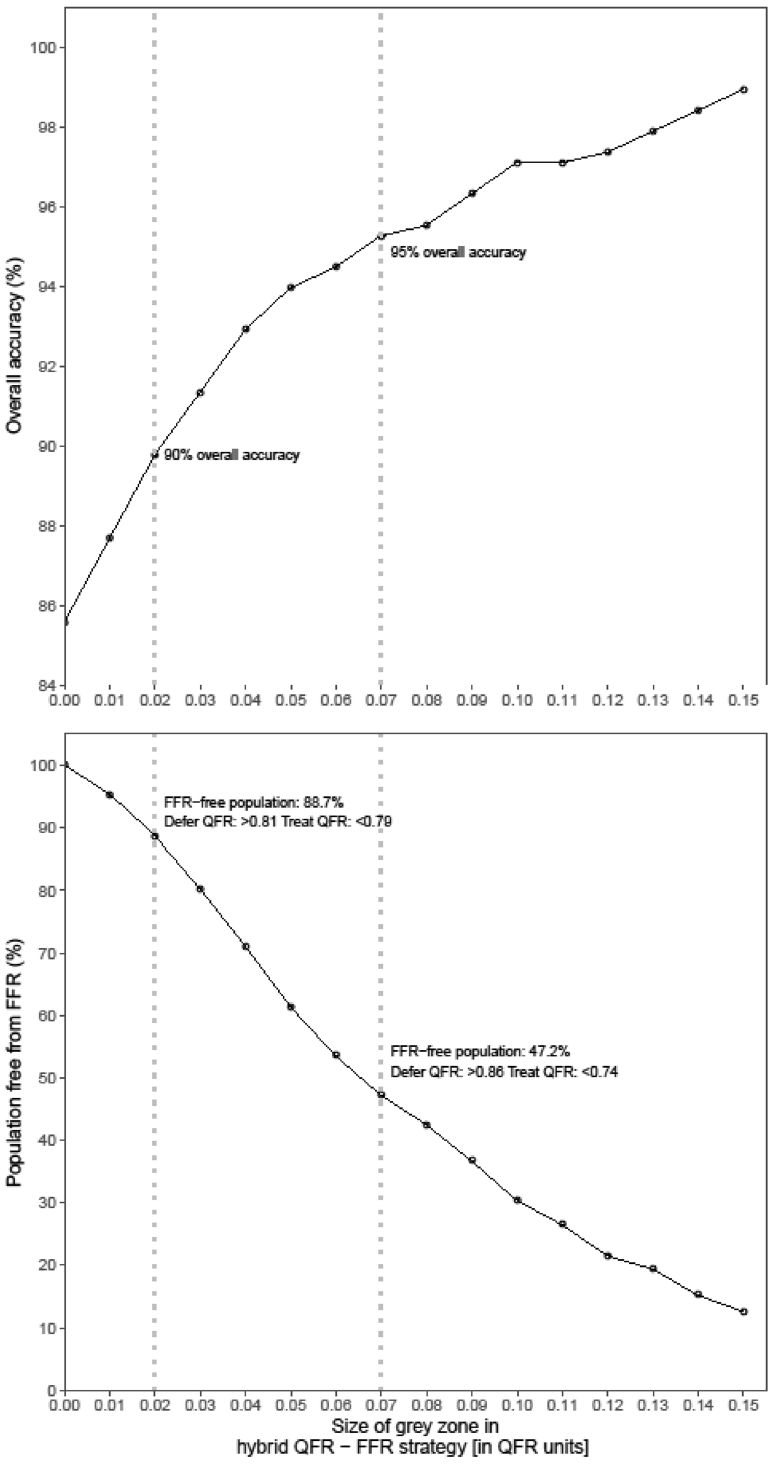
Figure 3. The per-vessel correlation and agreement between QFR and FFR. ( A ) The per-vessel scatterplot shows a good correlation between QFR and FFR (r = 0.72, p < 0.001). ( B ) The Bland–Altman plot shows a small bias of 0.007 ± 0.058 of QFR versus FFR. ( C ) Per-vessels agreement by plotting agreement against the average of invasive FFR and QFR value. QFR shows a high accuracy except for FFR-values around the cut-off 0.80 (0.75–0.85). ( D ) The per-vessels receiver operating characteristic curves (ROC-curves) for QFR and QFR–FFR hybrid approach. The area under the curve was higher for QFR–FFR hybrid approach (AUC = 0.92) versus QFR (AUC =